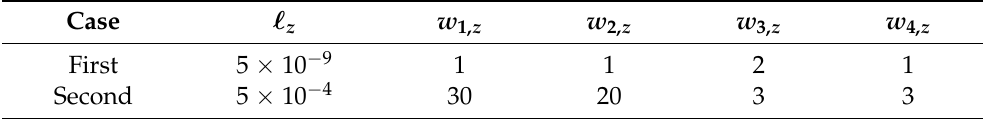
Table 3. Parameters for the adaptive framework in experiment